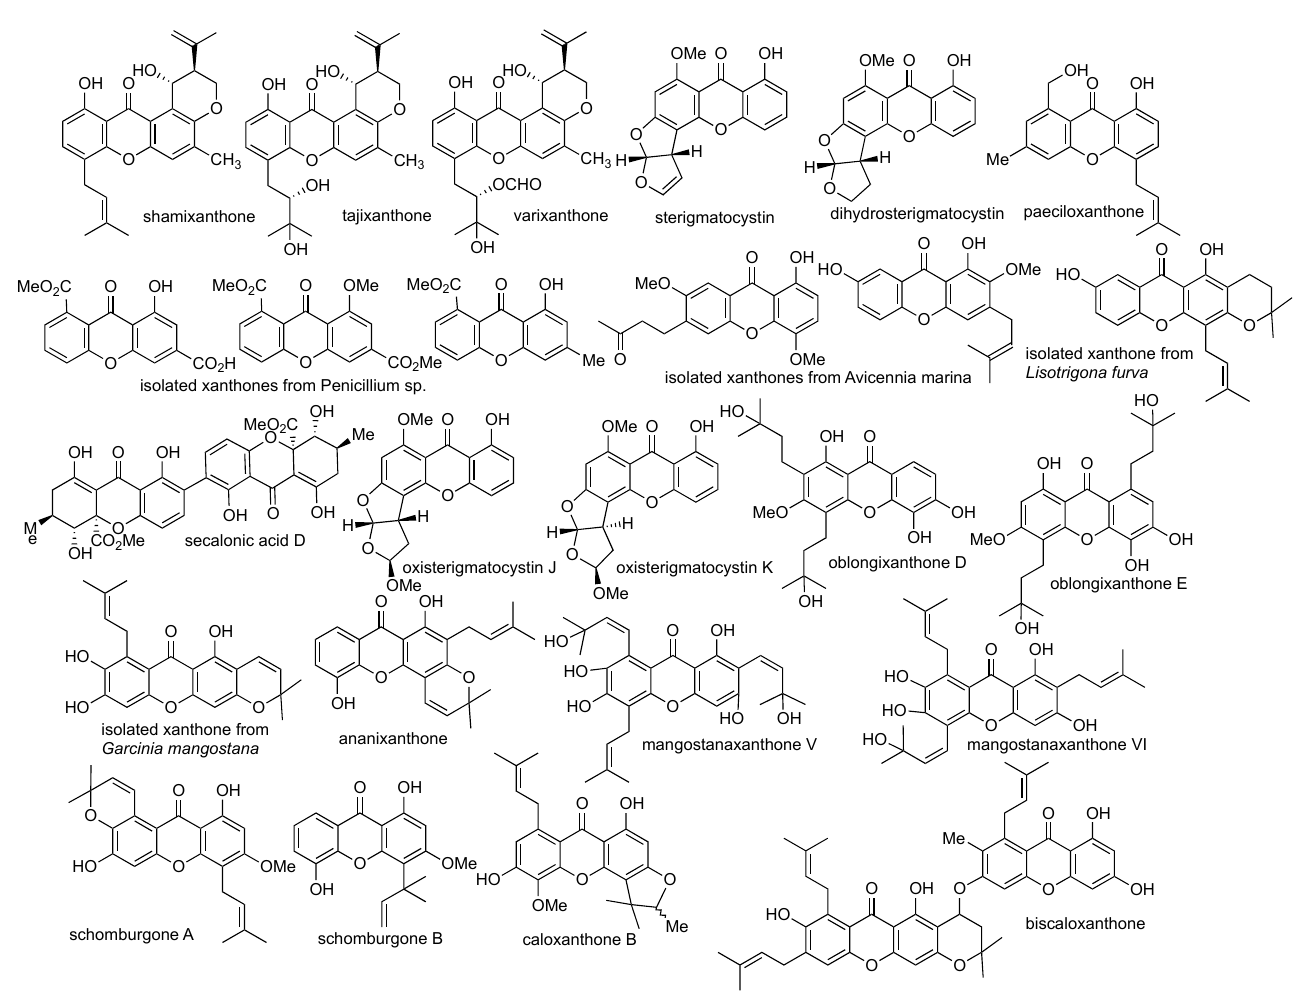
Figure 5. The chemical structure of isolated xanthone derivatives from natural sources.